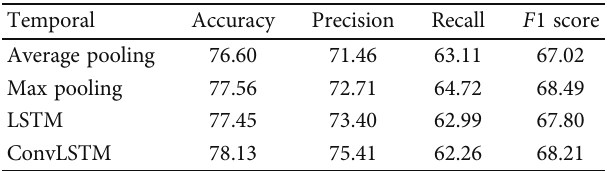
Table 4: E ff ects of temporal correlation modeling.